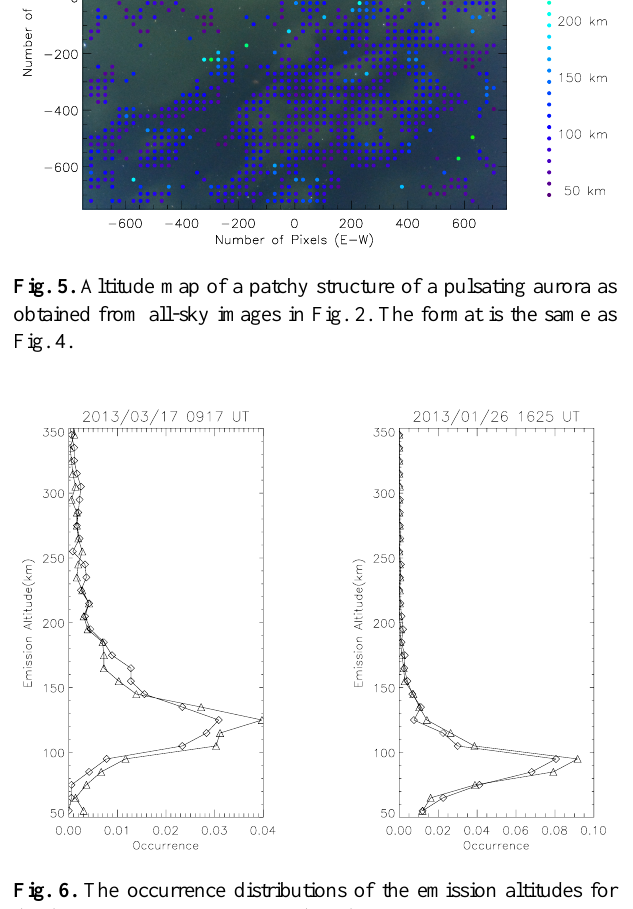
Fig. 6. The occurrence distributions of the emission altitudes for (left) the ray structure, and for (right) the patchy structure, as also shown by the dots in Figs. 4 and 5, respectively. Diamonds are from the altitude map as calculated starting from the base window in PI1, and triangles are from the altitude map as calculated starting from the base window in